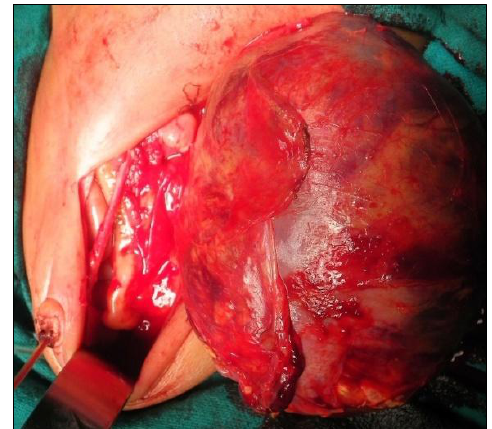
Figure 1: Intraoperative picture showing large Wilms’ tumor.